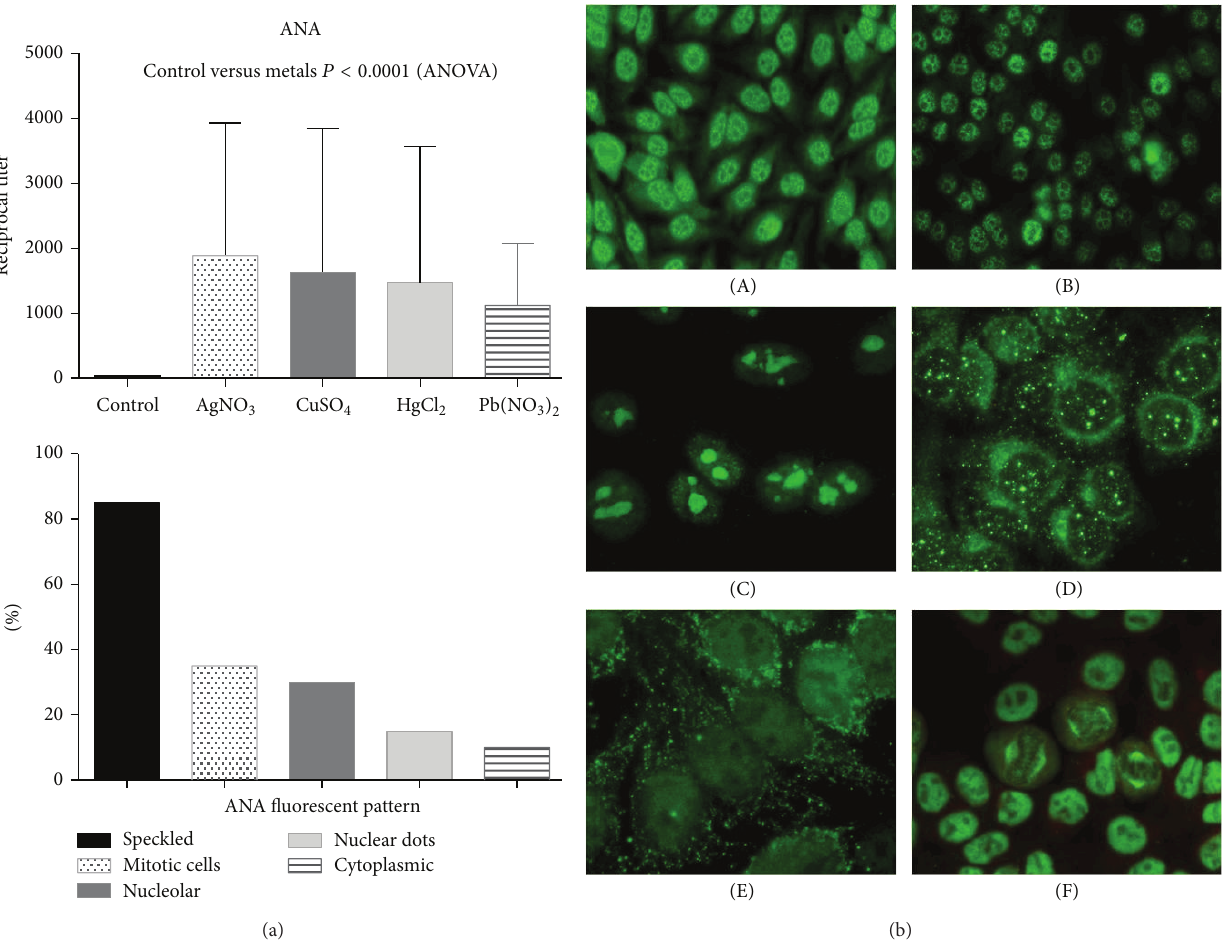
Figure 2: Indirect immunofluorescence assay graphs. (a) Antinuclear antibody (ANA) reciprocal titers using HEp-2 cells. The graphs show the mean and standard deviation (SD) and frequency of fluorescent patterns. And below is a graph showing the frequency of fluorescent patterns. On (b) different representative examples of ANA patterns: (A) nuclear speckled and cytoplasmic, (B) nuclear speckled, (C) nucleolar, (D) nuclear dots, (E) cytoplasmic, and (F) mitotic cells with staining of the nuclear mitotic apparatus.